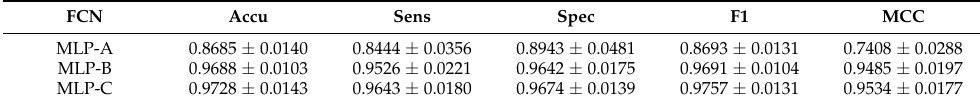
Table 4. The classification performance of the MLP models without any attention module.